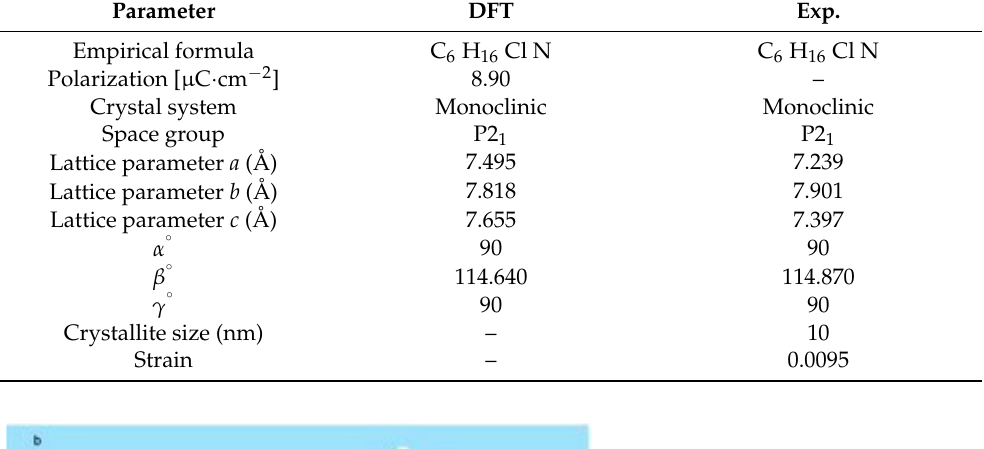
Table 1. The structural properties of polar monoclinic phase of DIPAC molecular crystal.